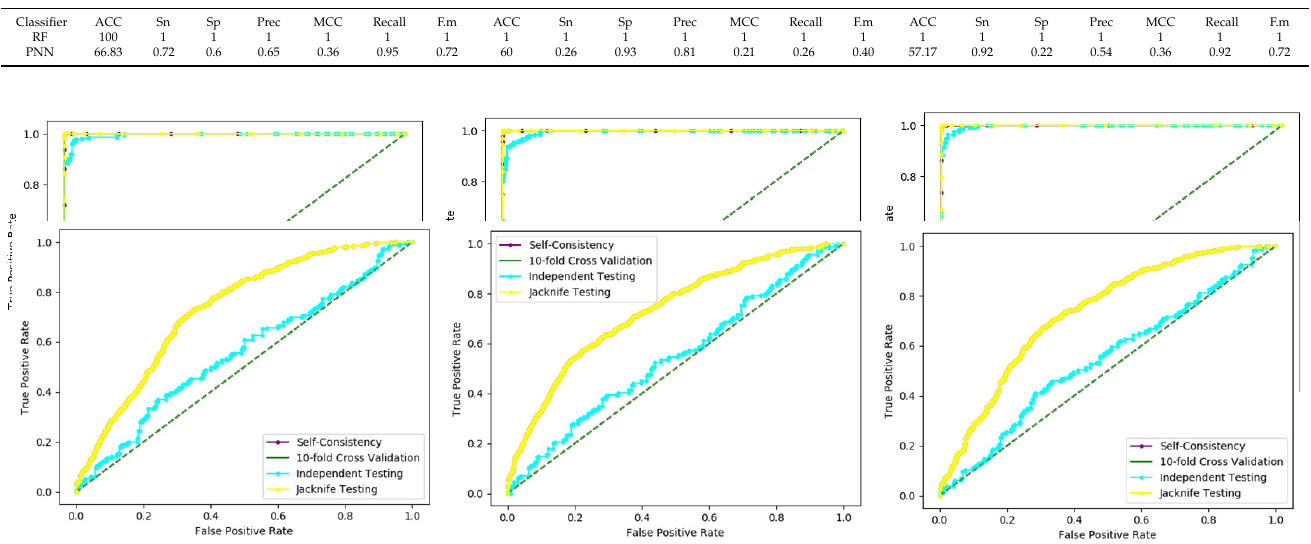
Figure 15. ROC curves through Random Forest.